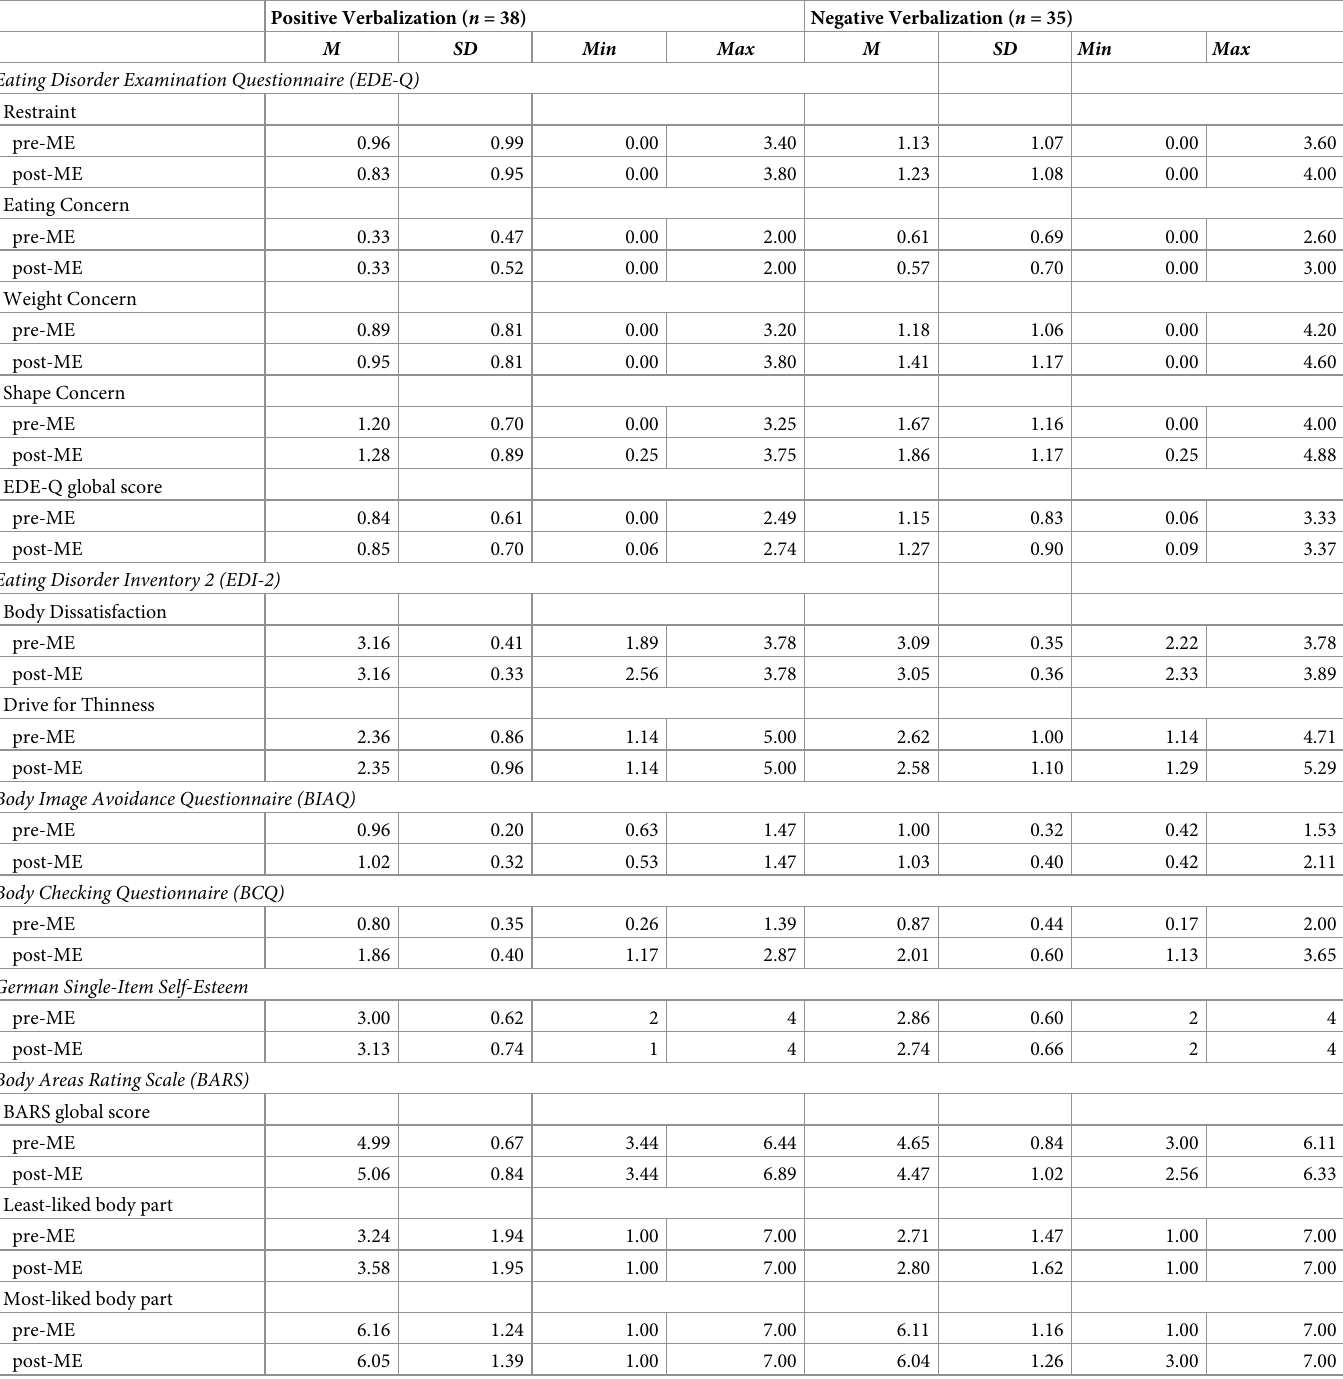
Table 1. Means and standard deviations for eating pathology, body image, self-esteem and satisfaction with body